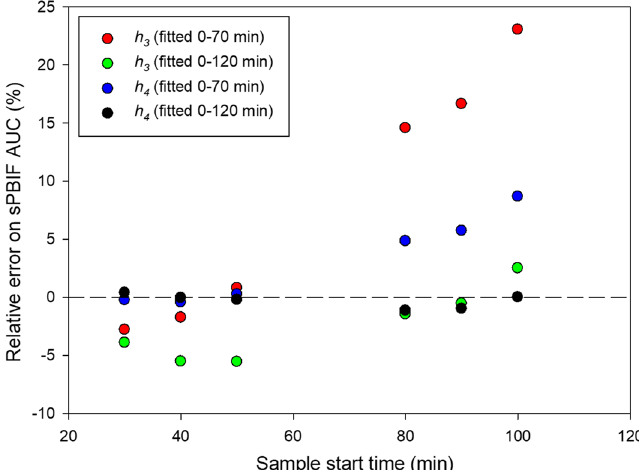
Fig. 3 Error AUC of sPBIF relative to AUC of AIF. The sPBIF was scaled using four blood samples with 5 min interval and scaling method 1. The relative errors are shown as a function of the sampling time of the 1st blood sample, and AUCs are calculated up to the sampling time of the 4th blood sample, e.g. for the data points at 30 min, we scaled the PBIF using blood samples at 30 min, 35 min, 40 min and 45 min, and the AUCs are calculated up to 45 min. Clearly, the best PBIF is based on h 4 and the use of data up to 120 min, as seen by the low AUC errors within 1%, i.e. best MR FDG